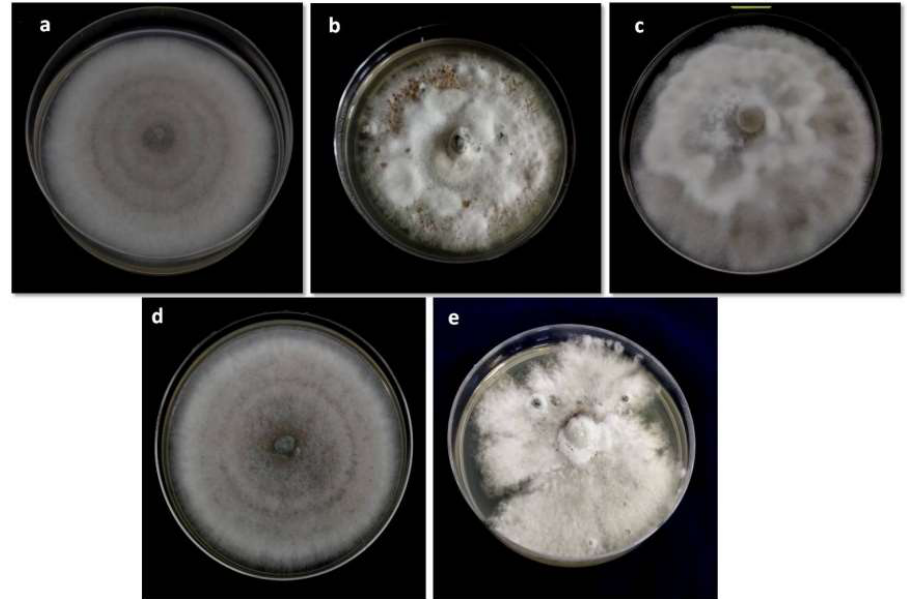
Figure 2. Colonies characteristics of C. falcatum based on topography type ( a ) Flat ( b ) Less fluffy ( c ) Raised fluffy; and margin type ( d ) Smooth ( e ) Irregular as observed in different isolates.